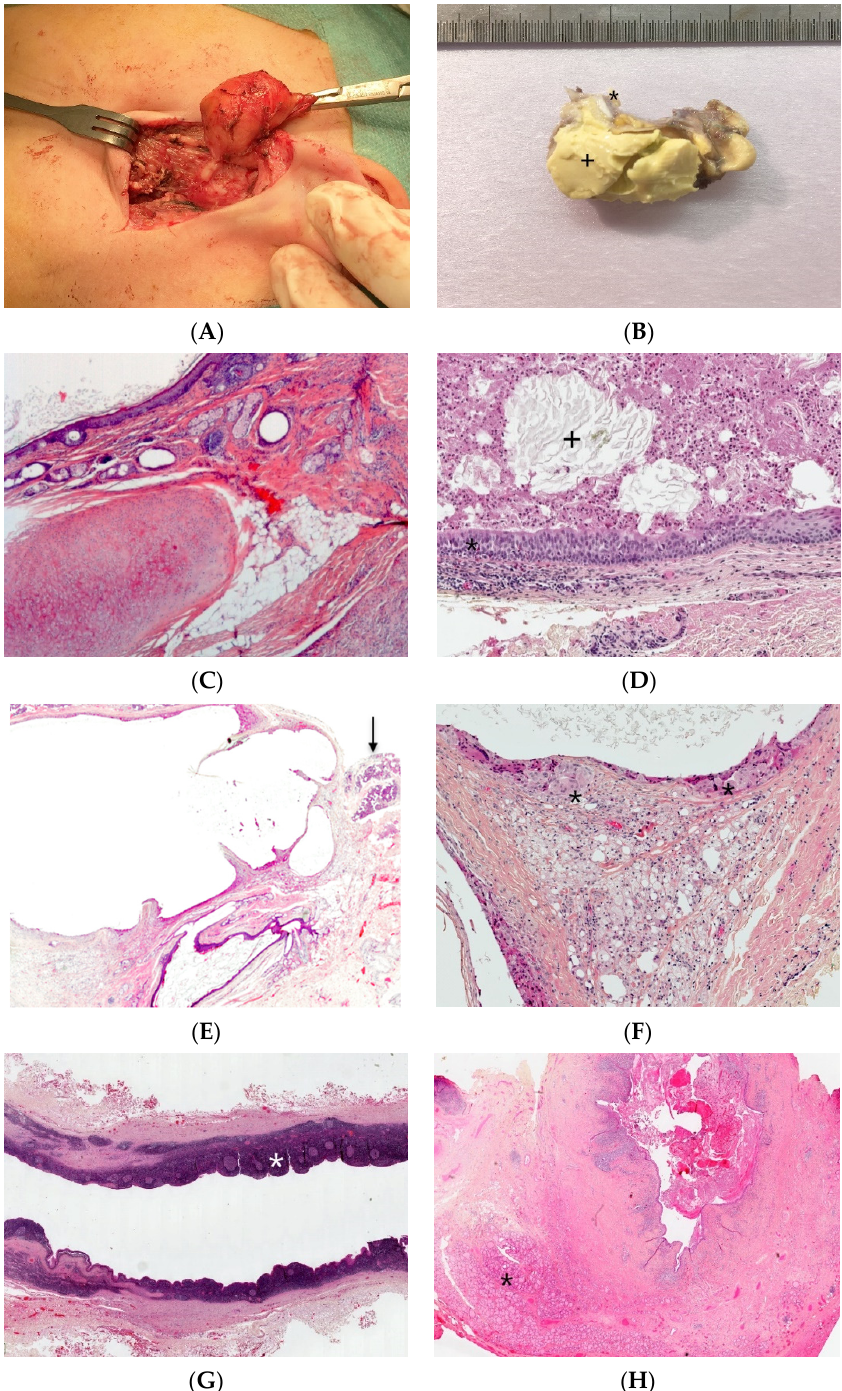
Figure 3. Branchial cleft cysts. First branchial cleft cyst ( A ), operating view. Periauricular type I cyst ( B ), gross examination. Cartilage (*) and necrosis (+) are visible. Periparotid type II with inflammatory changes ( C ) (H.E.S). lined by squamous epithelium and containing cartilage ( D ) (H.E.S). Lined by squamous epithelium and ciliated columnar epithelium (*). The lumen contains macrophages and squamous debris (+) ( E ) (H.E.S), located within the parotid gland (at the upper part, arrow), mainly denuded due to inflammatory changes ( F ) (H.E.S). The epithelial border is mainly replaced by foreign body giant cells (*). Lipid ‐ laden macrophages are observed in the cyst wall and squamous debris within the cyst lumen. Second branchial fistula ( G ) (H.E.S), lined by respiratory epithelium and confluent lymphoid follicles (*). Fourth branchial fistula ( H ) (H.E.S). The wall of the fistula contains thyroid tissue (*).